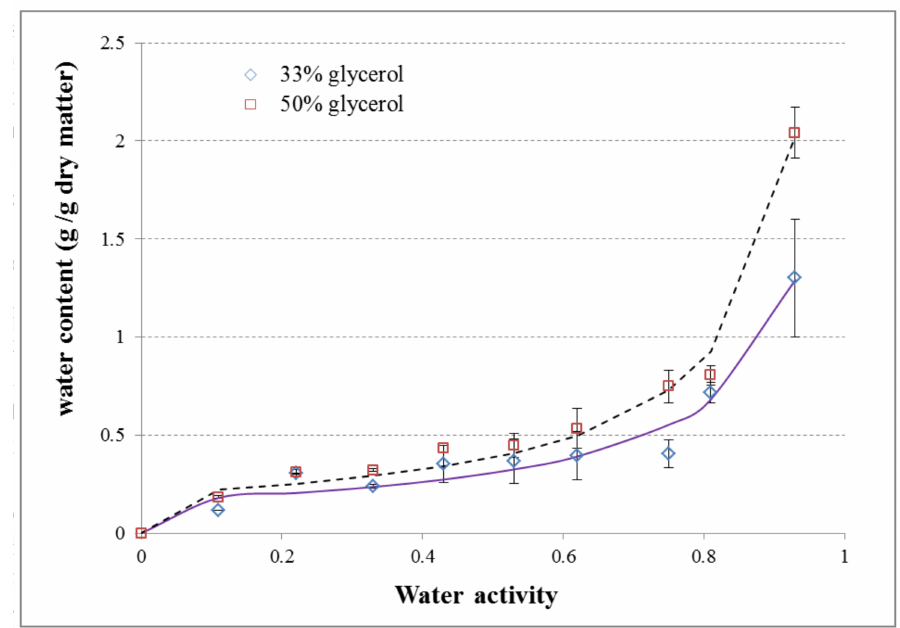
Figure 1. Moisture sorption isotherms of starch containing either 33% or 50% ( w / w ) glycerol in 5% starch solutions (g water /g · dm) at 25 ◦ C. Symbols are experimental values and lines values fitted by GAB